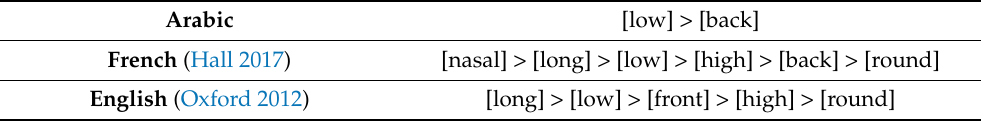
Table 2. Vocalic features.